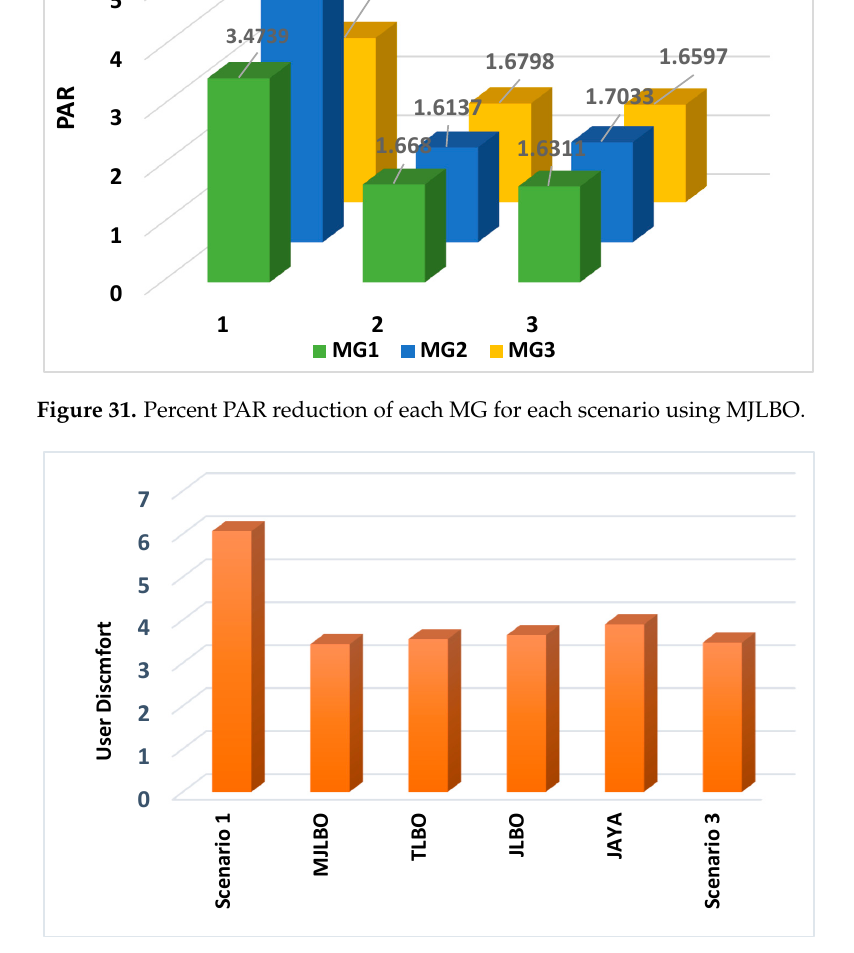
Figure 32. Combined system user discomfort scenario1, MJLBO, TLBO, JLBO, JAYA. and scenario 3.